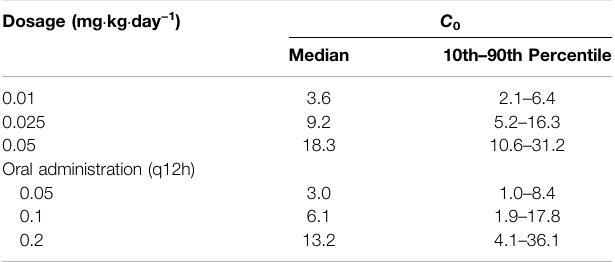
TABLE4| Simulations ( n =1,000)forthetypical pediatricHSCTtransplantpatient receiving different dosage regimens of tacrolimus. Dosage (mg · kg · day − 1